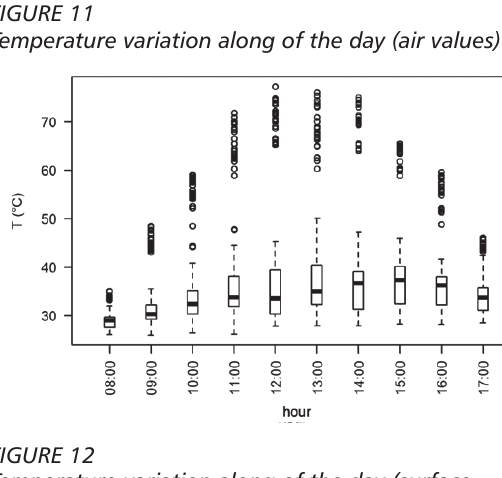
FIGURE 10 Temperature variation along of the day (total values) Temperature hourly variation (total values)